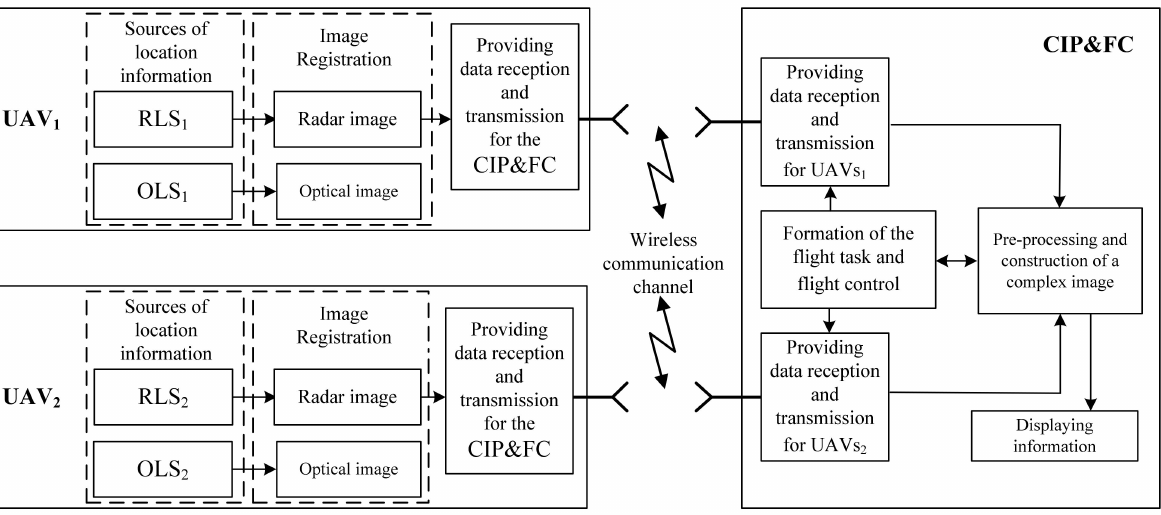
Figure 1. Block diagram of the radio-optical